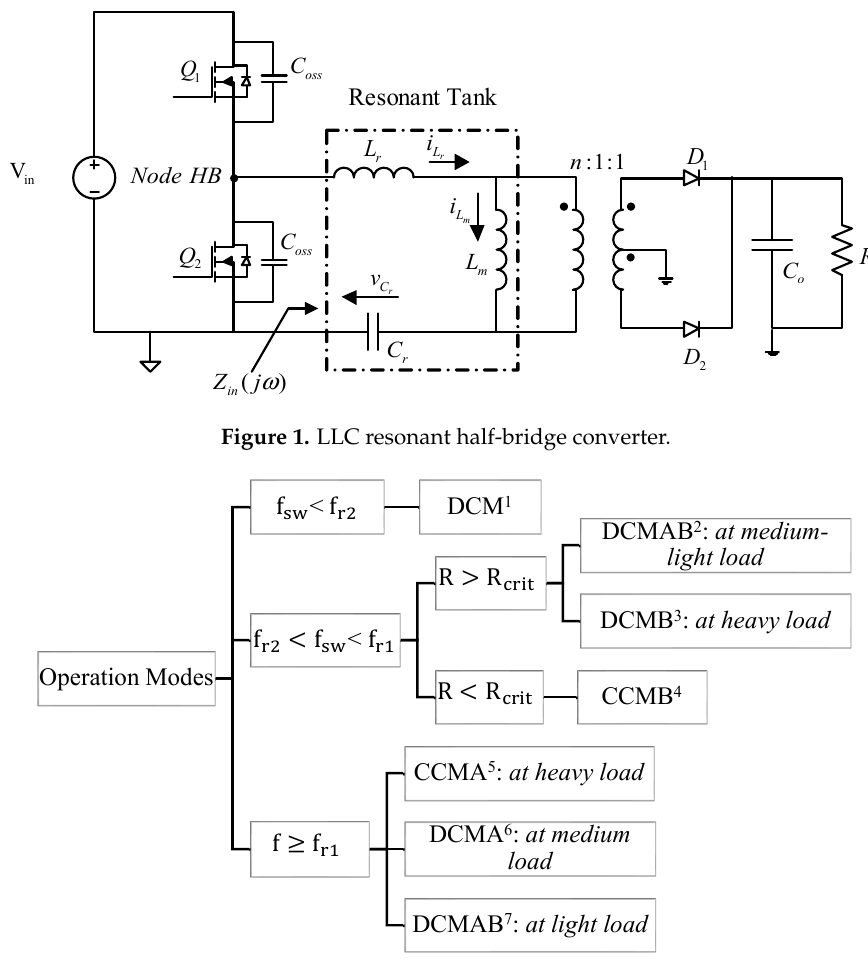
Figure 2. LLC resonant half-bridge converter.